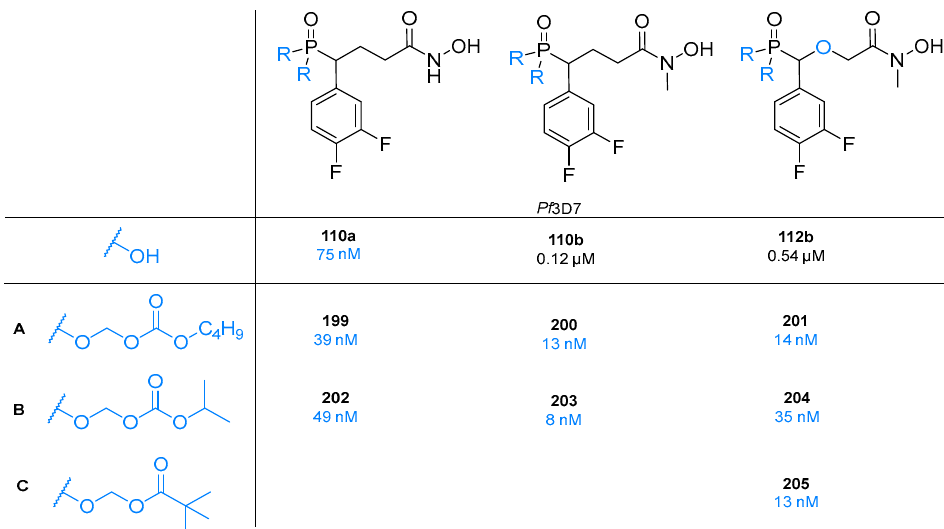
Figure 38. Inhibitory activity of rigidized prodrugs 206 – 208 against Pf Dd2 or Mt H37Ra.